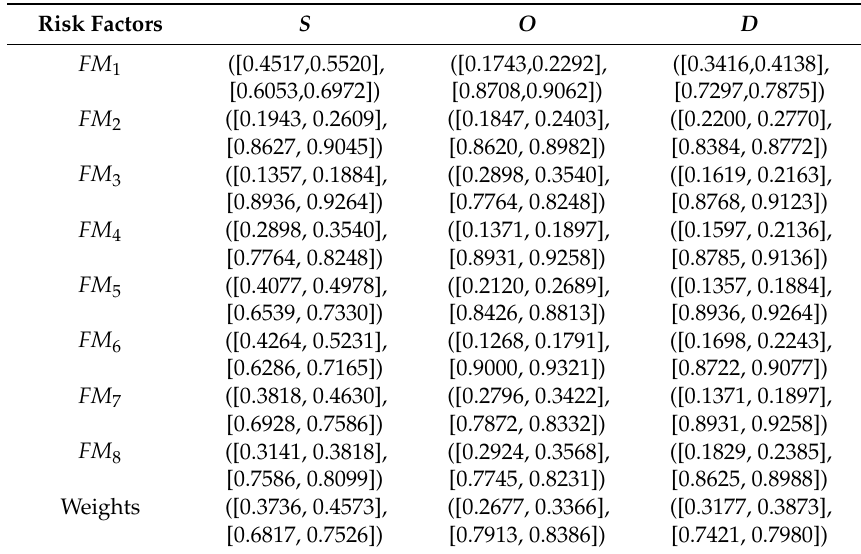
Table 5. Fuzzy collective evaluation matrix and aggregated fuzzy weights of risk